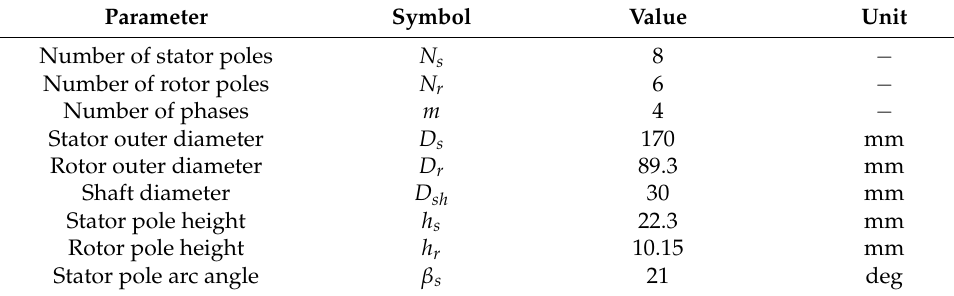
Table 2. Baseline parameters of the four-phase 8/6